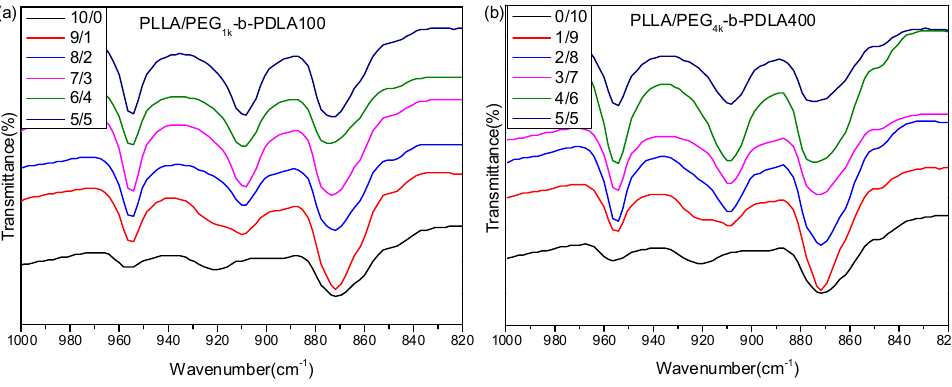
Figure 1. Fourier transform infrared spectrometry (FT-IR) spectra of PLLA/PDLA-PEG 1k -PDLA100 ( a ) and PLLA/PDLA-PEG 4k -PDLA400 ( b ) with different L/D ratios.